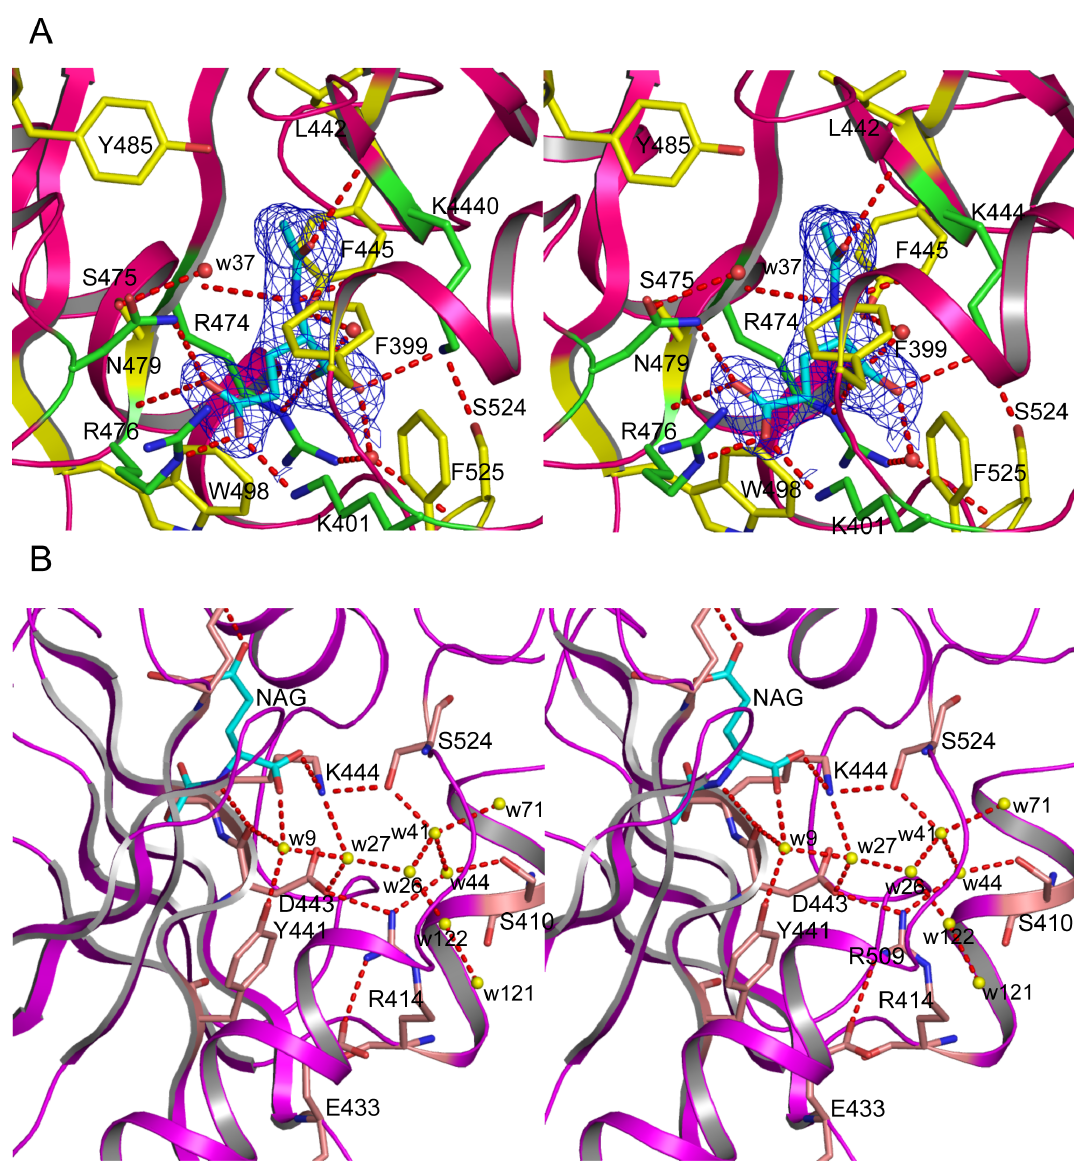
Figure 4. NAG binding site. A: Stereo diagram of NAG binding site. The bound NAG is shown in sky-blue sticks. The side-chains involved in hydrogen bonding interactions with NAG are shown in green sticks. The side-chains of other surrounding residues are shown in yellow sticks. The water molecule (w37) is shown in red ball. The electron density map (2F o –F c ) around bound NAG (contoured at 1.0 s ) is shown as blue cage. Potential hydrogen bonding interactions are shown in red dashed lines. B: Stereo diagram of ‘‘water wire’’ channel. The bound NAG is shown in sky-blue sticks. Water molecules are shown in yellow balls. Residues involved in hydrogen bonding interactions are shown in brown sticks. Potential hydrogen bonding interactions are shown in red dashed